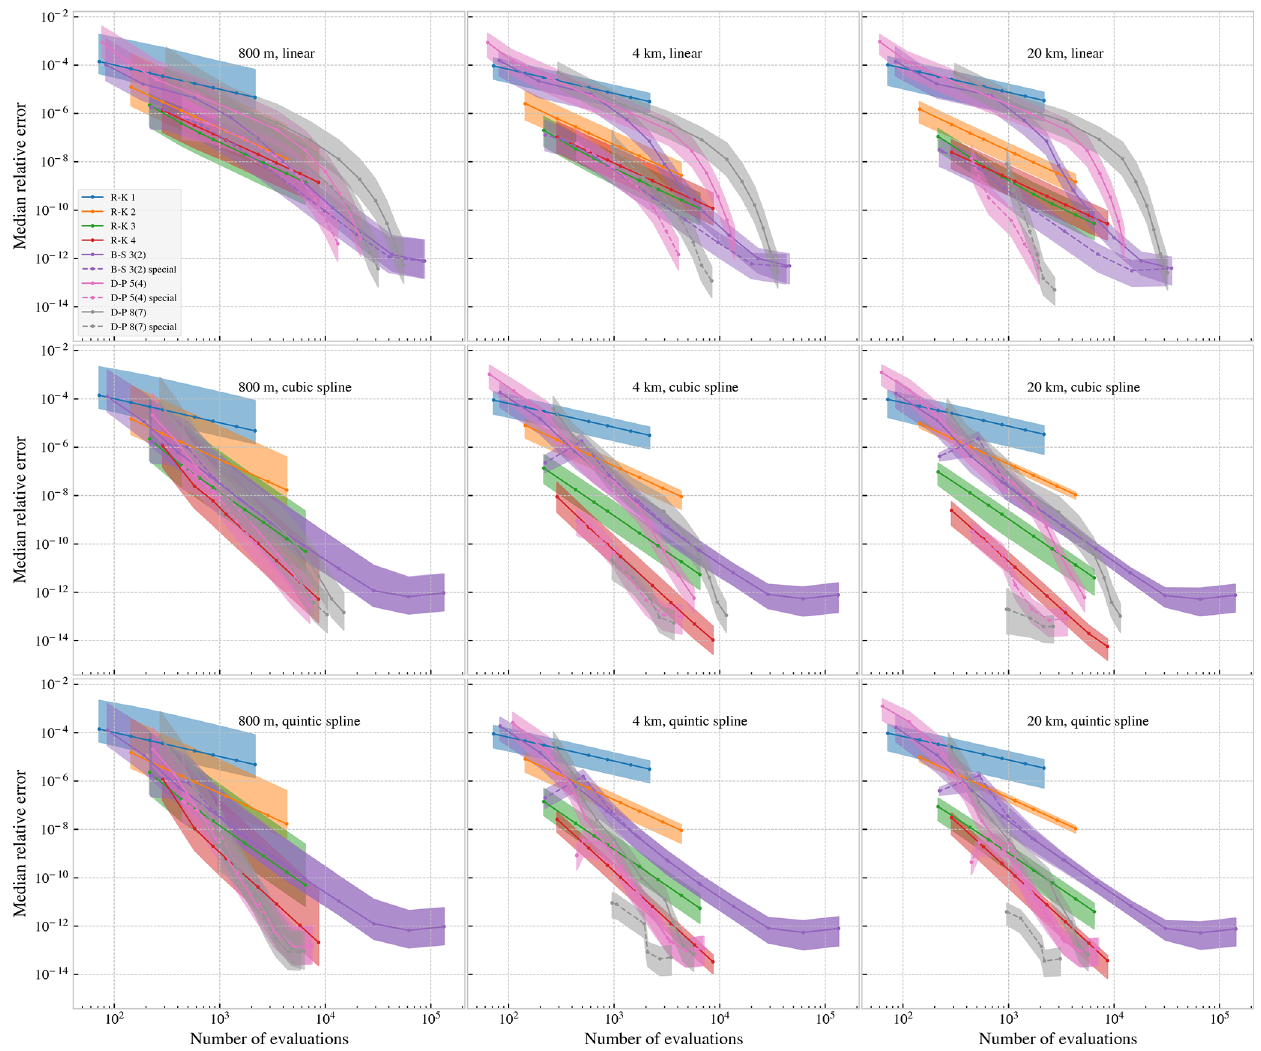
Figure B1. Same as Fig. 5, showing the median relative error taken over all 10000 trajectories. Additionally, the shaded areas show the range where 90% of the errors